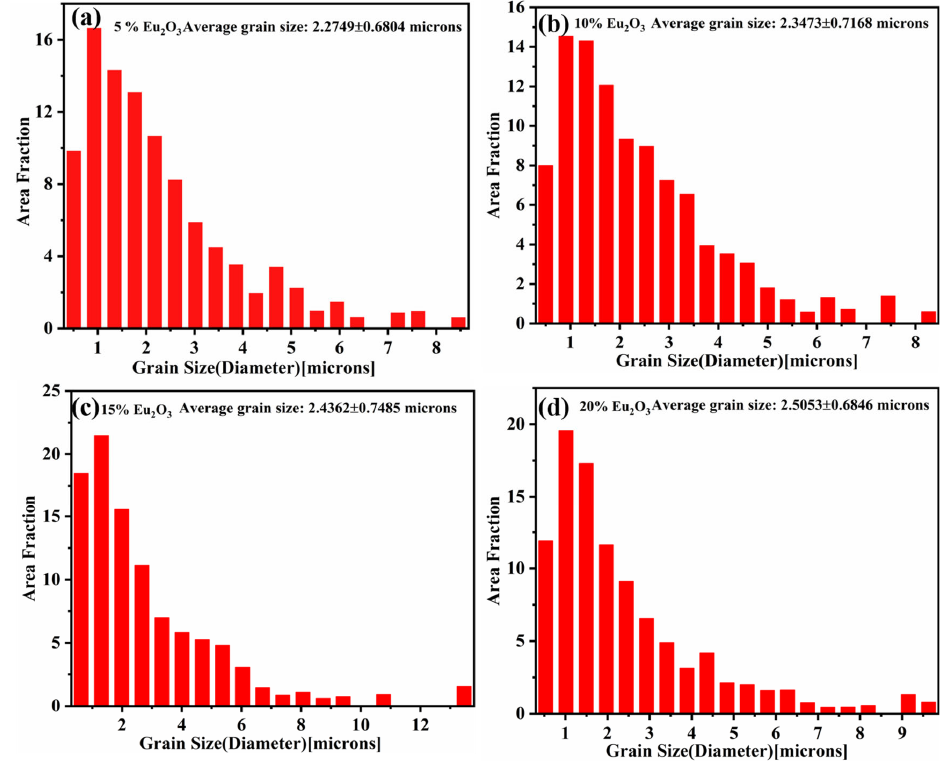
Figure 7. Grain size distribution of the composites: ( a ) HP5; ( b ) HP10; ( c ) HP15; ( d ) HP20.